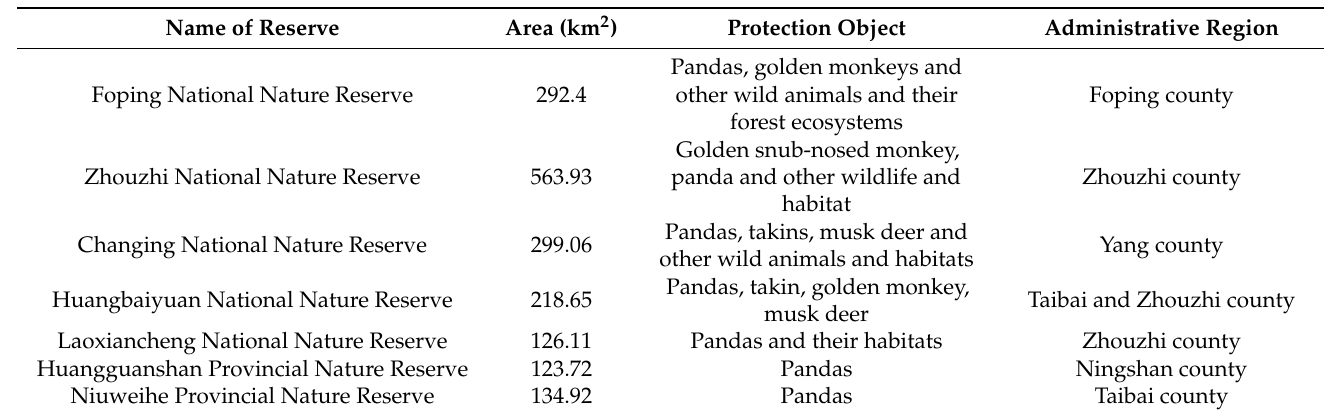
Table 1. The profile of protected areas in Qinling